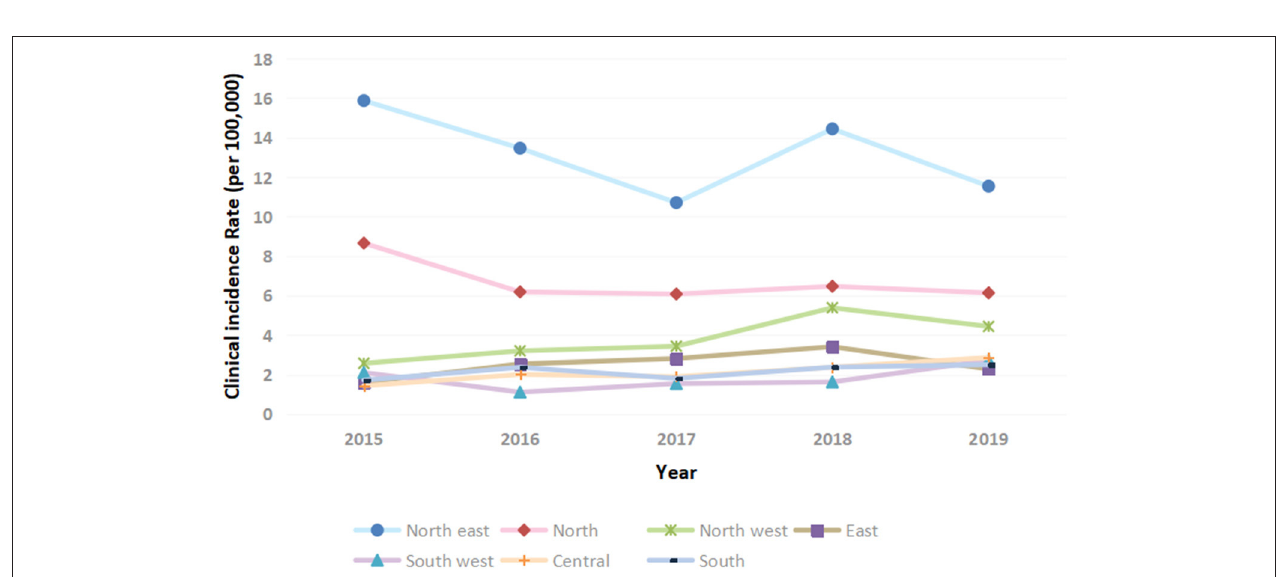
FIGURE 2 | Clinical incidence of T1DM in children and adolescents in China stratified by geographical